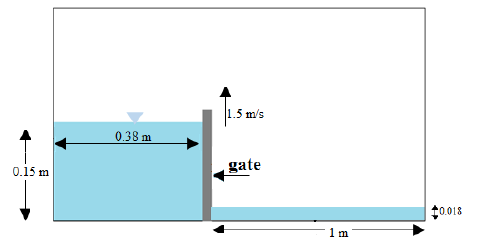
Figure 6 Initial geometry of gradually collapse of free water column (dam-break) with initial height of 0.15 m and gate velocity of 1.5 m/s.